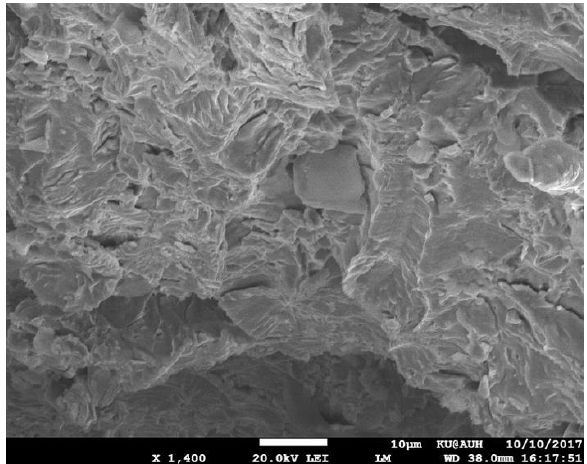
Figure 16. Cleavage fracture morphology of the internal blister/HIC crack wall.